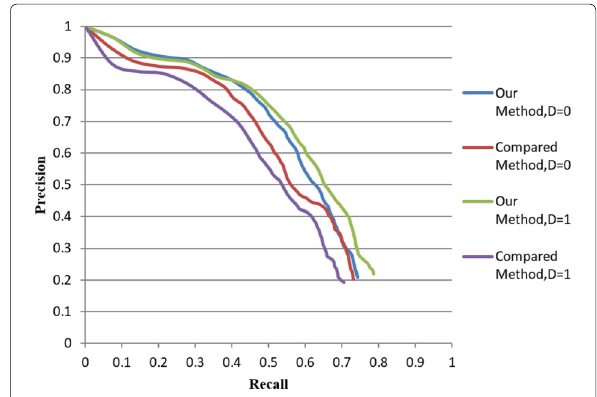
Fig. 10 Performance comparison for the proposed and baseline similarity ranking